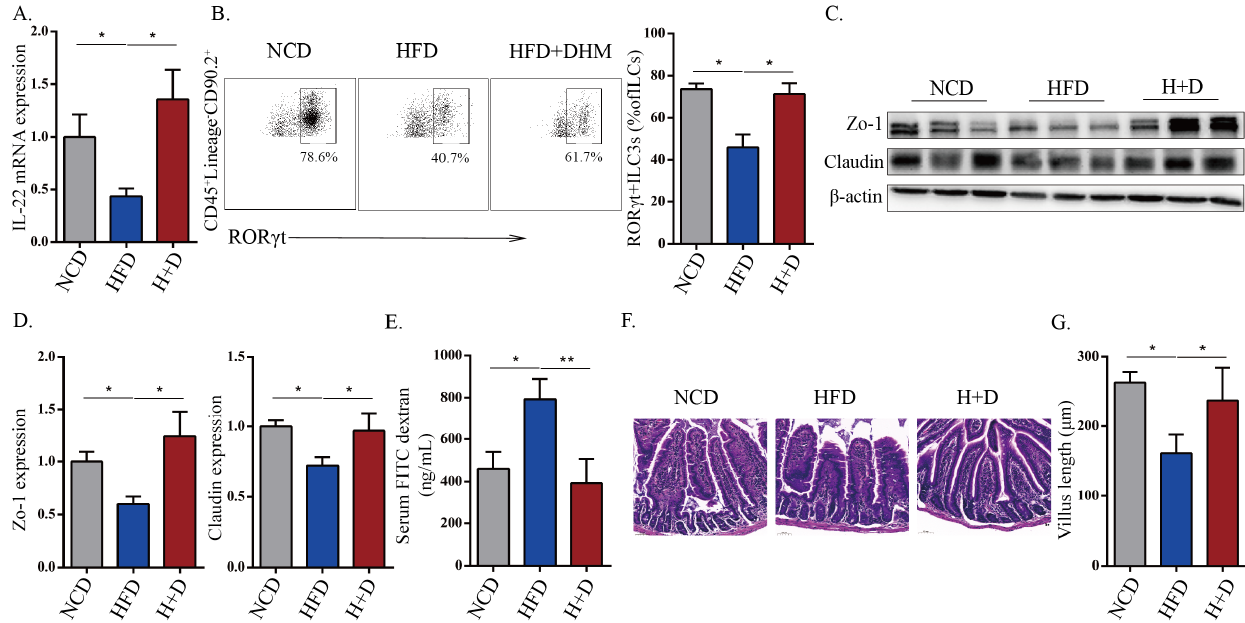
Figure 2. DHM protected against HFD ‐ induced intestinal barrier destruction, which was associated with an increase in IL ‐ 22, and increased ILC3 frequency. ( A ) The relative expression of IL ‐ 22 in small intestine tissues of the indicated mice was calculated via qRT ‐ PCR. ( B ) Calculation of the frequency of ROR γ t+ ILC3 cells (CD45+ lineage ‐ CD90.2+ROR γ t+) derived from the small intestine in the indicated mice. The numbers in the flow plots represent a percentage of ILC3s in each gate. ( C , D ) The mRNA and protein expression levels of ZO ‐ 1 and claudin in small intestine tissues of the indicated mice were calculated via Western blotting (3 samples/group). β‐ actin was used as a loading control. ( E ) Serum FITC–dextran (4 kD) intensities of indicated mice. ( F ) Hematoxylin and eosin (H&E) of the small intestinal tissues. Scale bars = 50 μ m. ( G ) Villus length of small intestinal tissues in the indicated mice was calculated according to ( F ). * p < 0.05, ** p < 0.01, as determined by one ‐ way ANOVA followed by the Tukey–Kramer post hoc test.